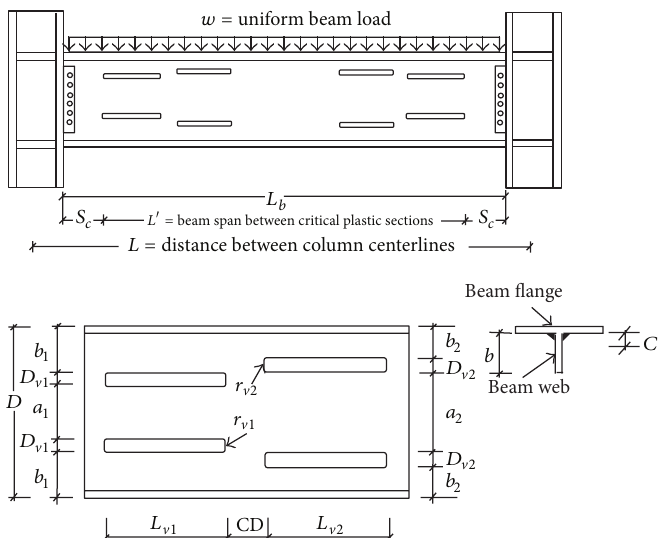
Figure 3: Modified post-Northridge connections with multilongitudinal voids. Table 1: Geometric parameters of SAC specimens.